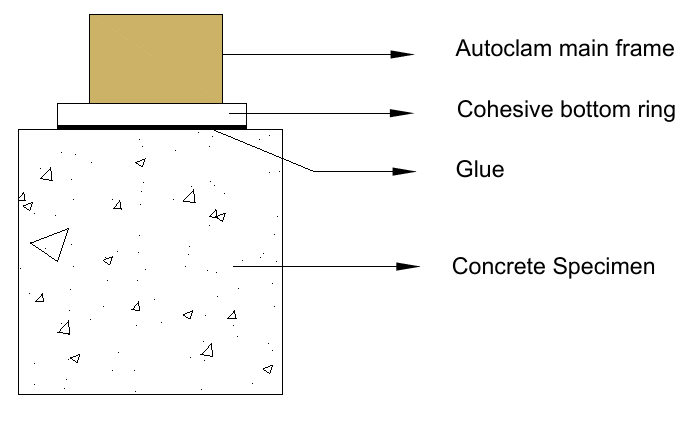
Figure 10. Autoclam permeability test